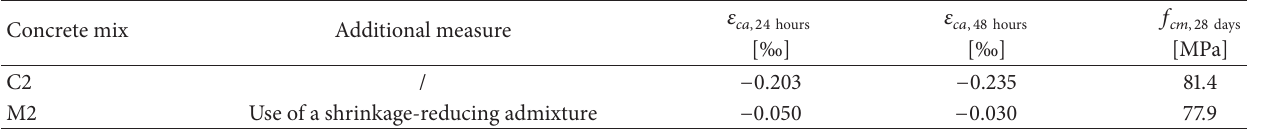
Table 6: Comparison of the autogenous shrinkage of 24- and 48-hour-old concrete, without and with a shrinkage-reducing admixture, and their associated 28-day compressive